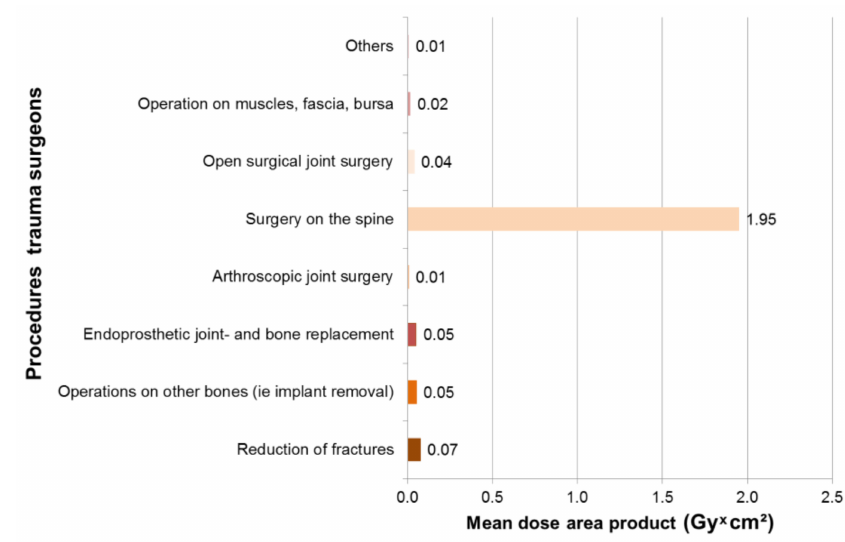
Figure 3. Mean dose area product for trauma surgeons, according to procedure type.